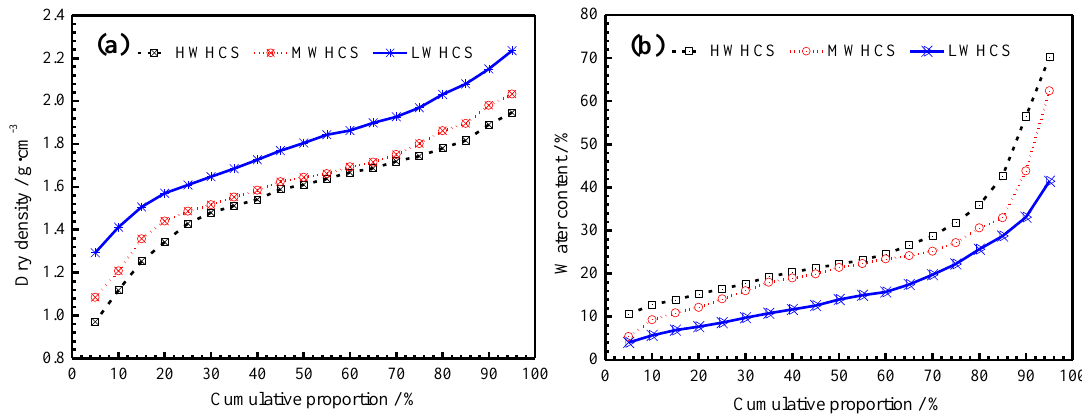
Figure 8. ( a ) Dry density and ( b ) water content cumulative proportion of three soil clusters.